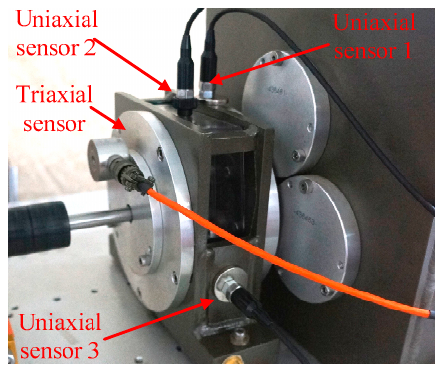
Figure 3. Arrangement of test points and vibration acceleration sensors.